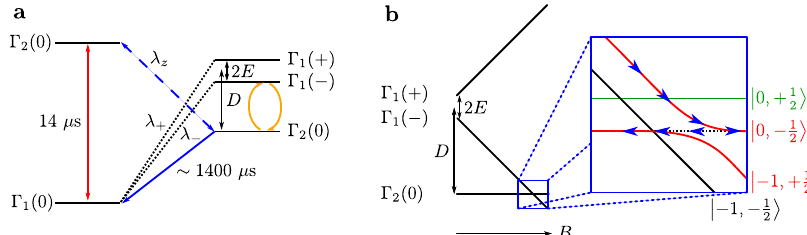
Fig. 3 Proposed quantum protocols. a Quantum protocol for ODMR in C-centre. The red and blue arrows show fl uorescence and phosphorescence, respectively. The blue dashed arrow highlights the spin-selective ISC leading to the main contribution to phosphorescence. The dotted lines represent the weak ISC to the ground state. Orange lines correspond to coherent spin control using microwave excitation. The spin – spin interaction incorporates both dipolar spin coupling and the re-normalisation effect from the spin-orbit interaction. The spin- selective ISC initialises the bright 0 j i spin state. Applying spin rotation leads to a contrast in the phosphorescence emission. b Magnetic fi eld dependence of the triplet electronic and doublet nuclear spin levels labelled by m S ; m I j i . Procedure for the Landau-Zener transition is (cid:9) (cid:9) highlighted for negative hyper fi ne coupling parameters. The initial superposition (green and red) of electronic states α 0 ; þ 1 (cid:9) 2 (cid:9) transferred to the coherent superposition of nuclear states α 0 ; þ 1 2 sake of